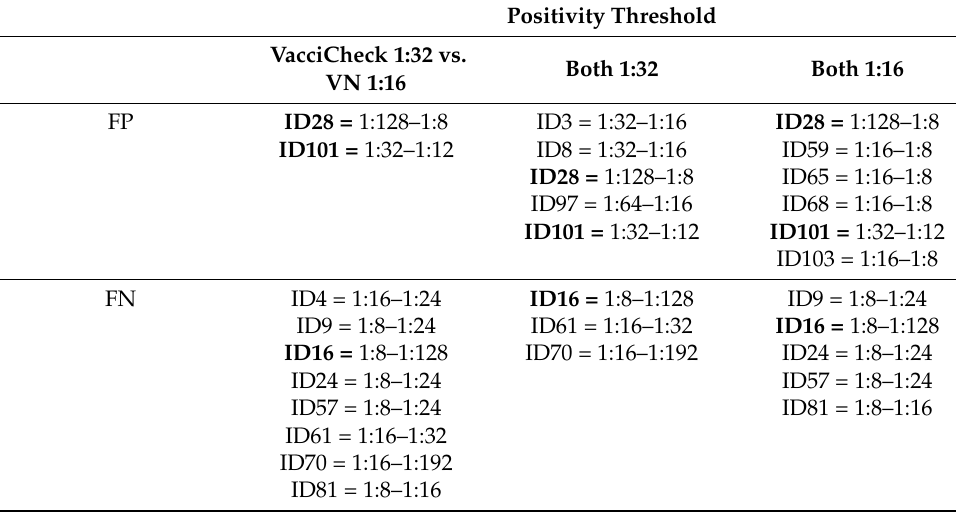
Table 3. Discordant result (false-positive and false-negative VacciCheck) compared to the gold stan- dard (virus neutralization). For each sample are reported the antibody titer measured by VacciCheck (first titer) and VN (second titer). In bold are samples that resulted discordant for all the three thresholds examined. Positivity Threshold VacciCheck 1:32